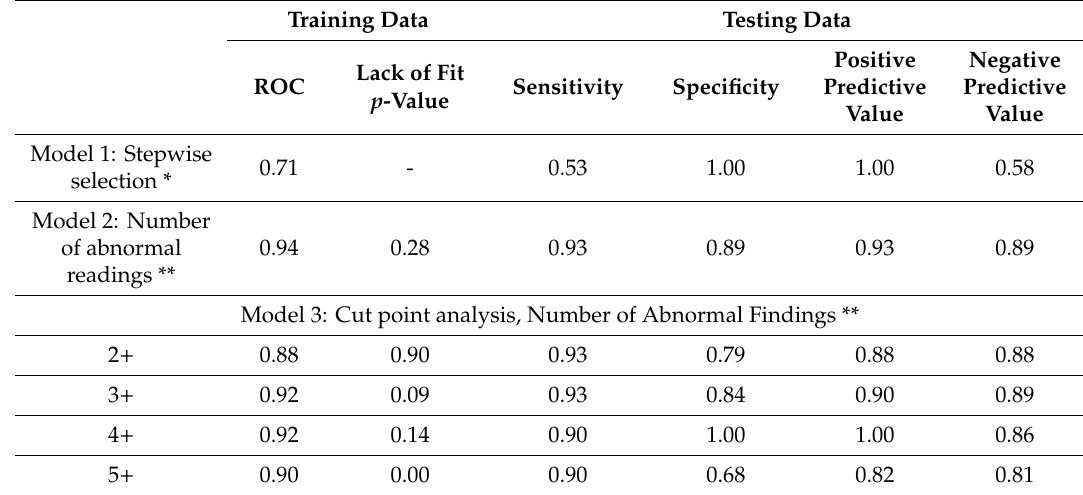
Table 4. Diagnostic test accuracy results of each of the 3 statistical